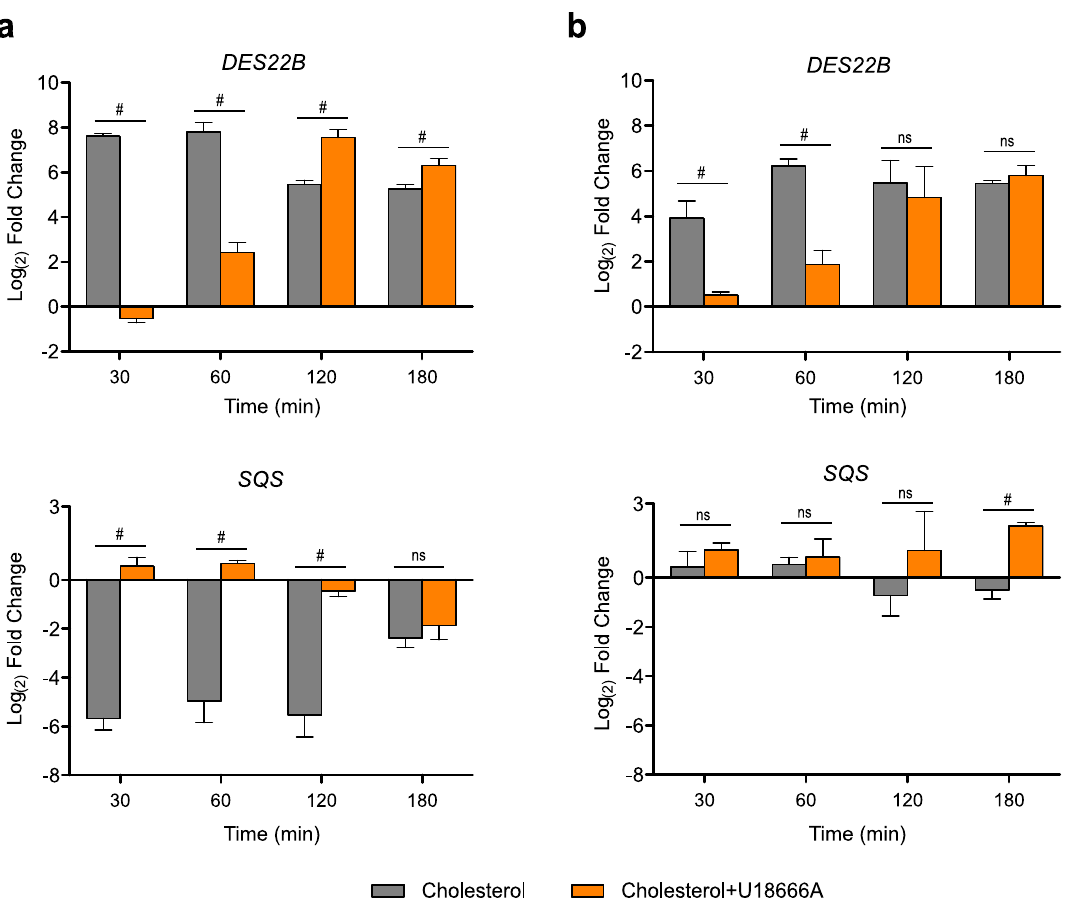
Figure 7. U18666A delays changes in the expression of cholesterol-regulated genes. Time course of the expression of DES22B and SQS in wild - type ( a ) or phagocytosis-deficient ( b ) cells. Cultures at exponential growth phase were incubated with 2 μM U18666A or vehicle for 15 min prior to the addition of 26 μM cholesterol. Total RNA was extracted at different times after treatment with cholesterol and gene expression was analyzed by RT-qPCR. Data are expressed as mean ± SD (n = 3) log 2 fold change relative to untreated cells (before addition of U18666A or cholesterol) of the respective strain. Statistical analysis was performed by repeated measures two-way ANOVA with Bonferroni post hoc test to compare treatments at each time; # p < 0.05; ns, not significant